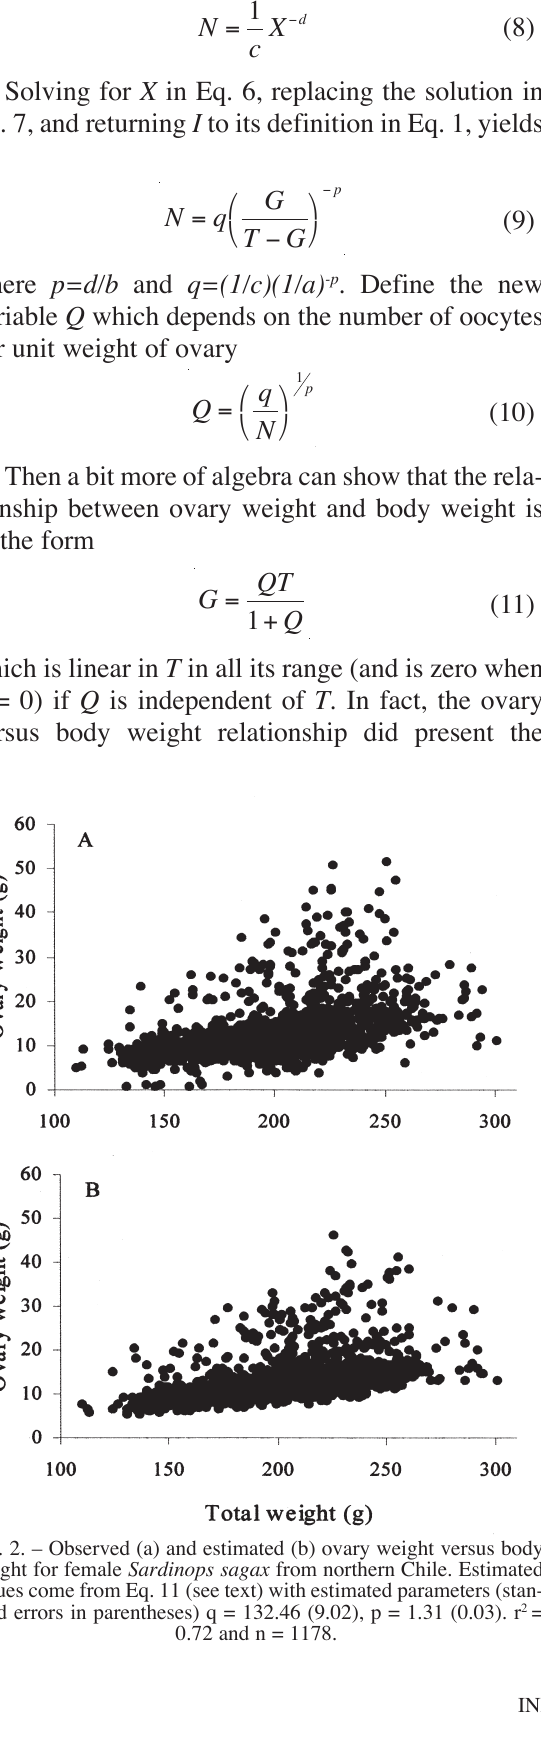
), calibrated standard devia- POF